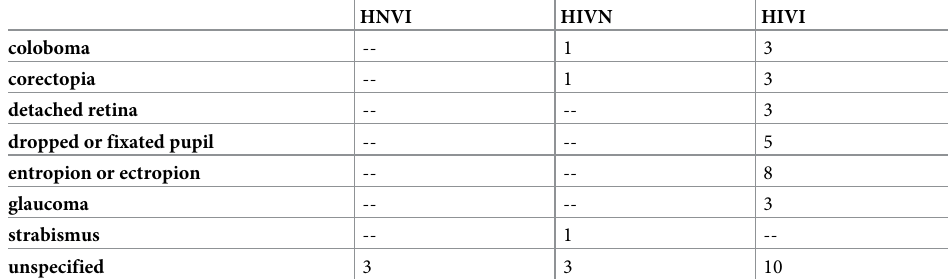
-- -- unspecified 10 Abnormalities are listed in alphabetic order. The “unspecified” response was for owners who responded "other ophthalmic abnormality than those mentioned above" but without specifying the exact type of the abnormality(s). The “--” symbol means that no dog was